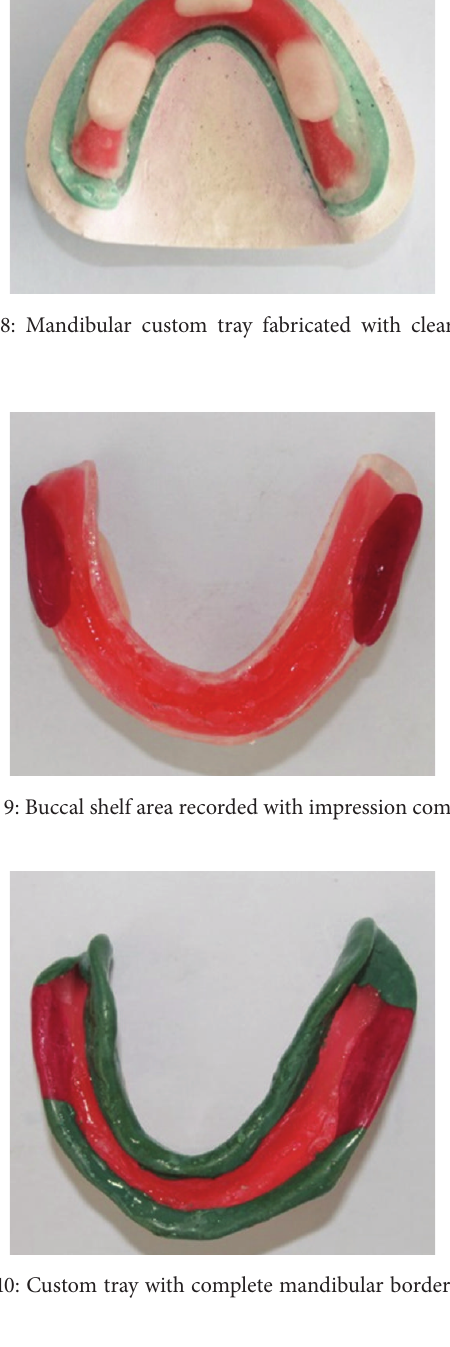
Figure 13: Maxillary custom tray with wax spacer